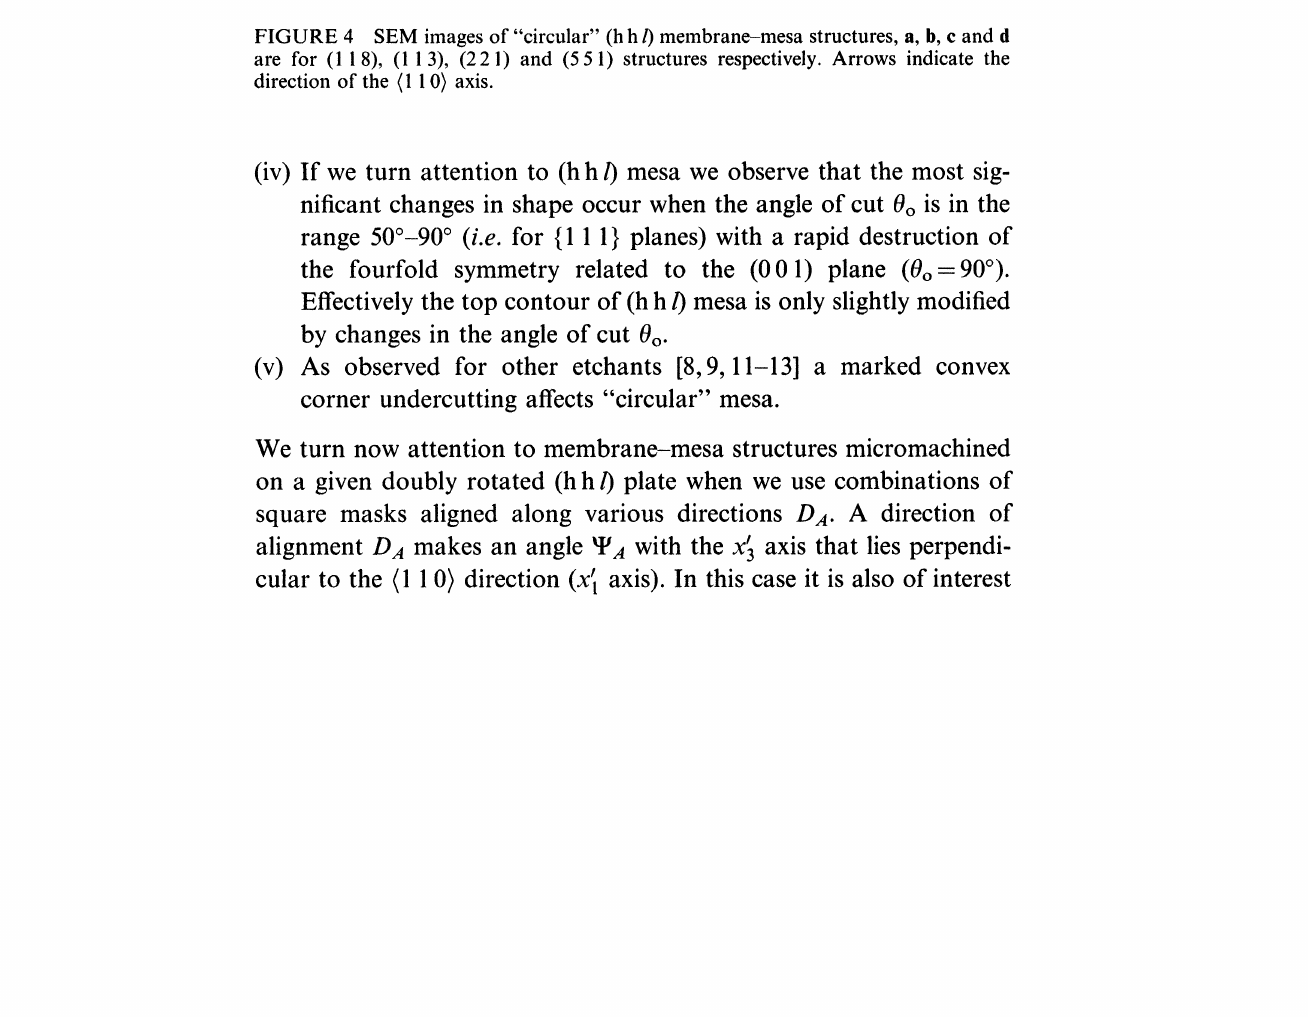
FIGURE 4 SEM images of "circular" (h h/) membrane-mesa structures, a, b, c and d are for (1 8), (1 3), (221) and (551) structures respectively. Arrows indicate the direction of the (1 10)